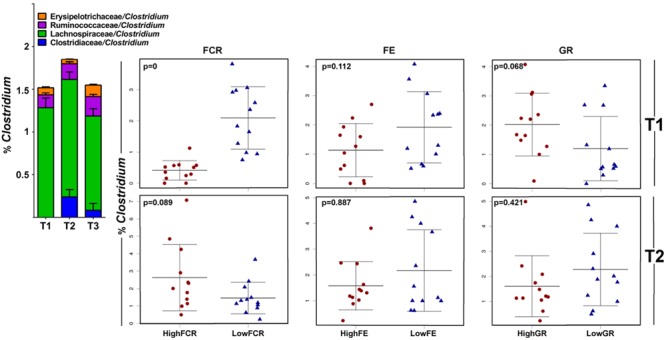
Different members of the genus Clostridium correlate with growth performance in different trials. In this analysis all genera listed as Clostridium were merged and the correlation of total Clostridium abundance is shown in stripcharts for Trial 1 (top row) and Trial 2 (bottom row); there were no differences in Trial 3. Clostridium species had lineages split between families Clostridiaceae, Ruminococcaceae, Lachnospiraceae, and Eryspelotrichaceae. The trial 1 Clostridium community, with no members of the Clostridiaceae/Clostridium lineage (blue on the barchart above), correlated with improved FCR and slightly reduction in FE and increased GR. In Trial 2 (and more so in Trial 3), the Clostridiaceae lineage of Clostridium gave non-significant differences in the opposite FCR direction.